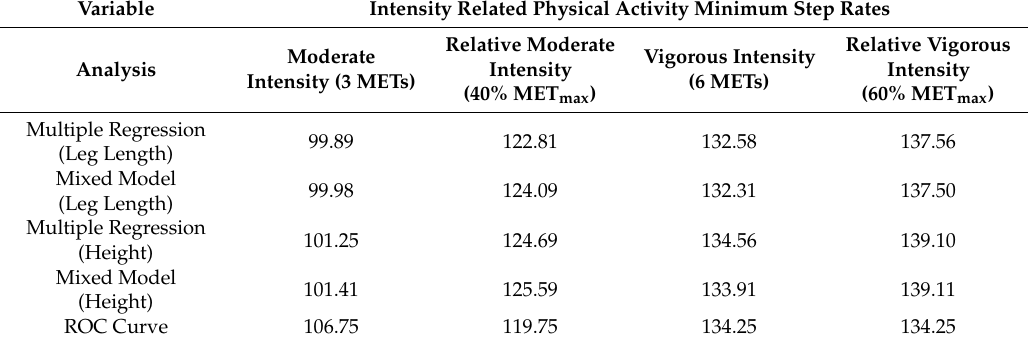
Table 2. Minimum step rates for both absolute and relative moderate and vigorous intensity walking as established using multiple regression, mixed model, and ROC curve